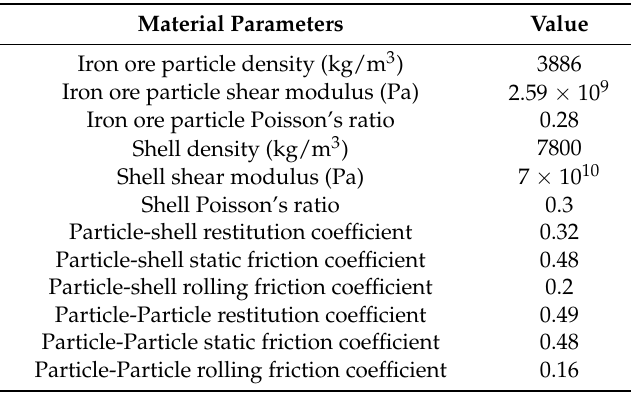
Table 3. The parameters of DEM